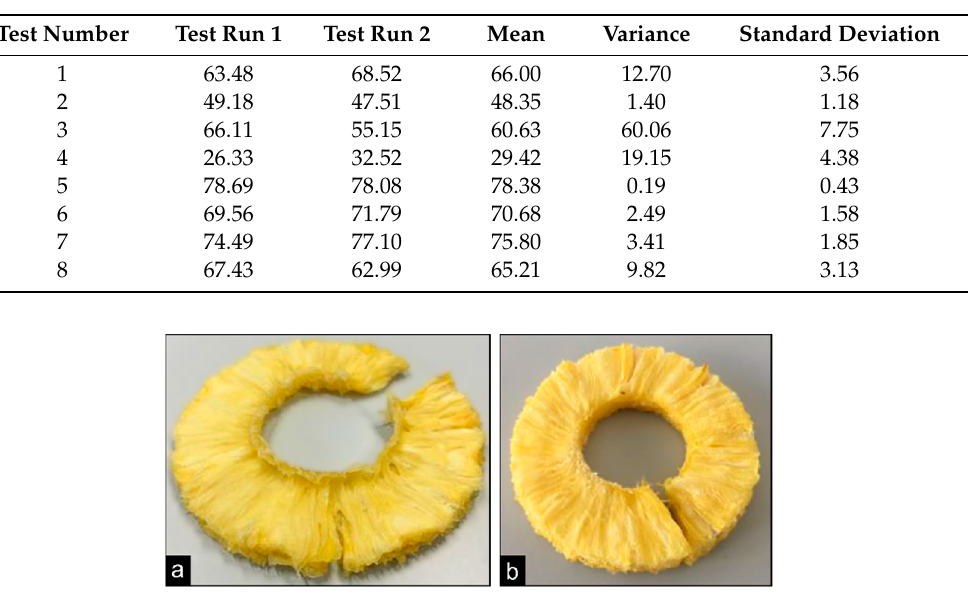
Table 6. Residual relative moisture content (wt %) for the eight tests comprising the full factorial design.